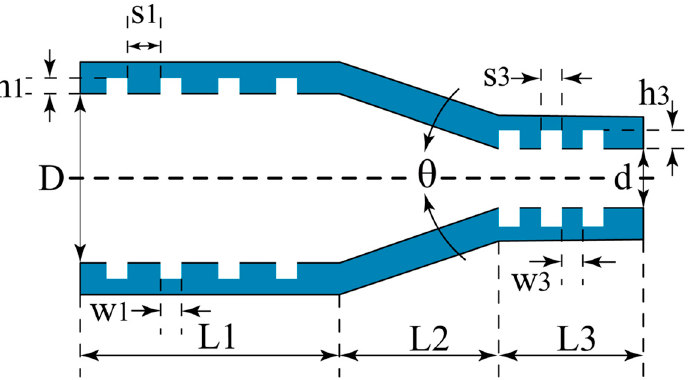
Figure 5. Concept diagram of BSCN.